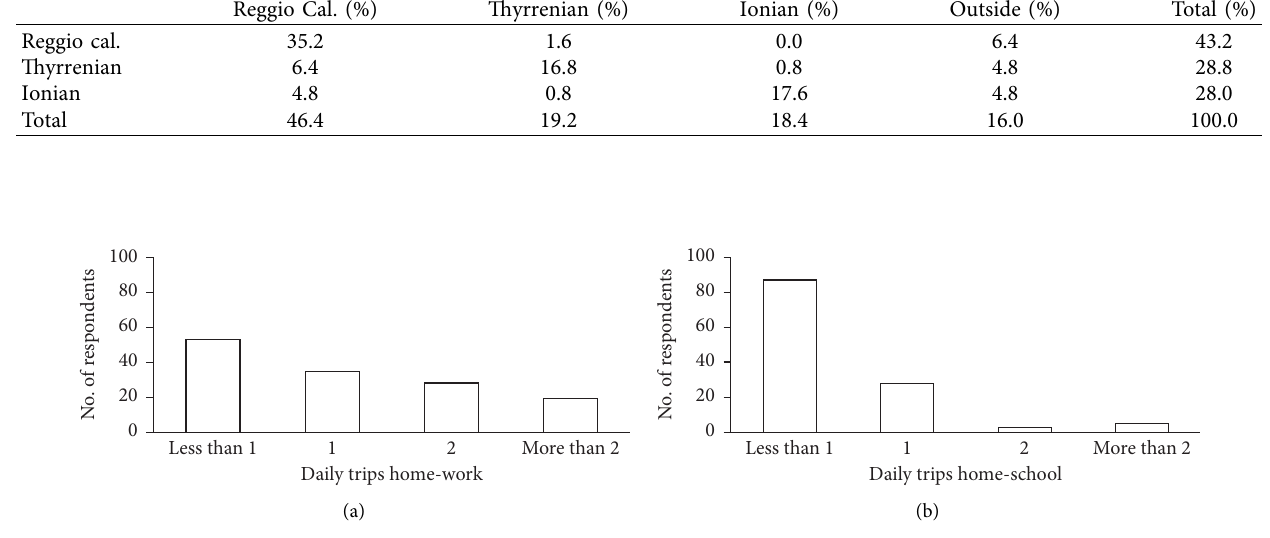
Figure 4: (a) Frequency of home-work trips; (b) frequency of home-school trips.